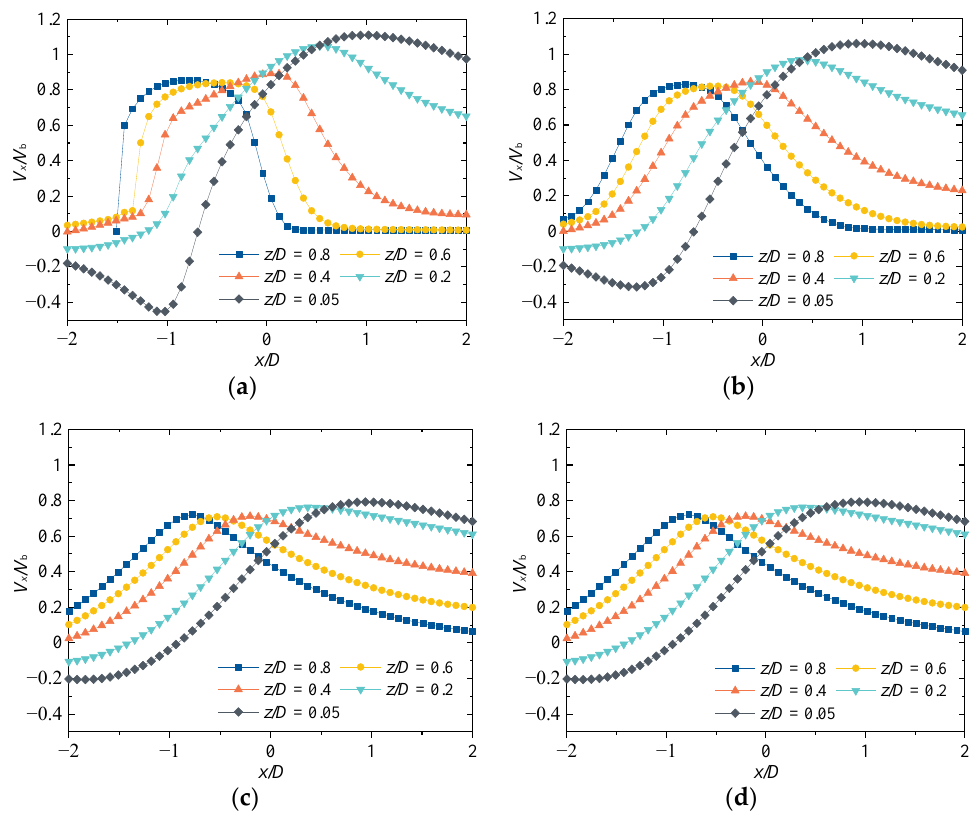
Figure 13. Development of mean vertical velocity ( |V z |/V b ) along the horizontal direction at different vertical locations on the near-well region: ( a ) H/D = 1; ( b ) H/D = 3; ( c ) H/D = 6; ( d ) H/D = 8.